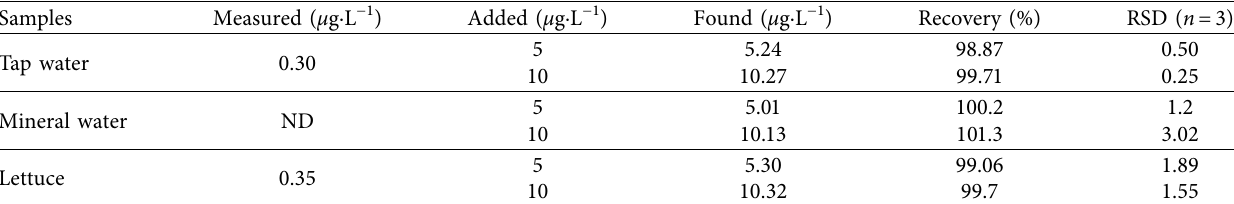
Table 4: Determination of lead in real